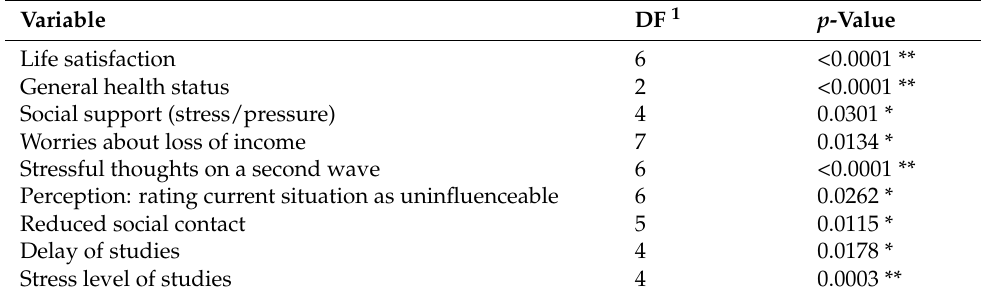
Table 2. Final model.